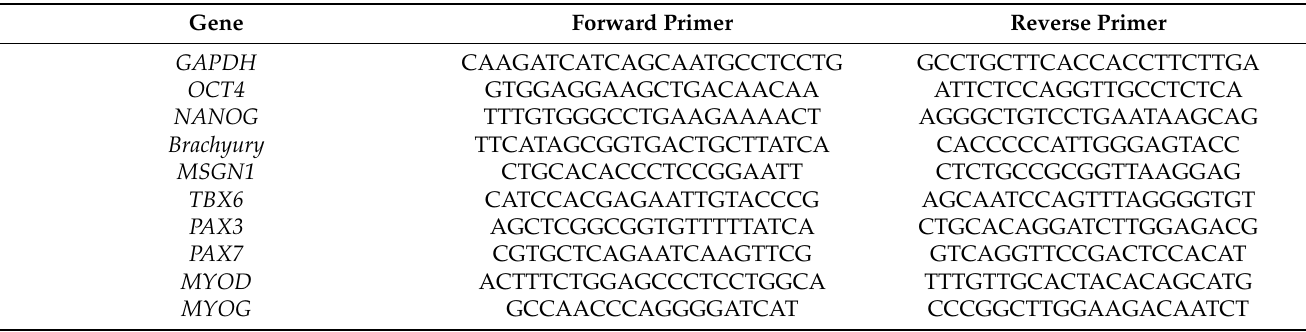
Table 2. Primers used for qRT-PCR